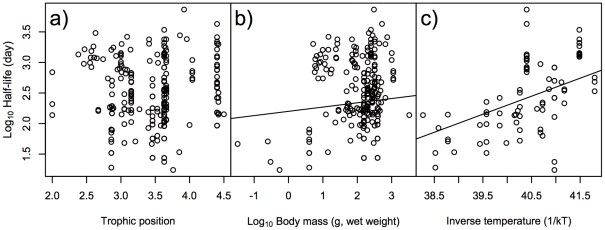
Effects of ecological/biological traits of species on half-lives of 137Cs activity concentration in fish.Effects of a) trophic position of species, b) body mass (g, wet weight) of species, and c) inverse temperature (1/kT) of the environment on log10 half-lives (day) of 137Cs activity concentration on fish. Lines indicate a significant relationship by the best GLMM, with the coefficient and intercept estimated by GLMM.